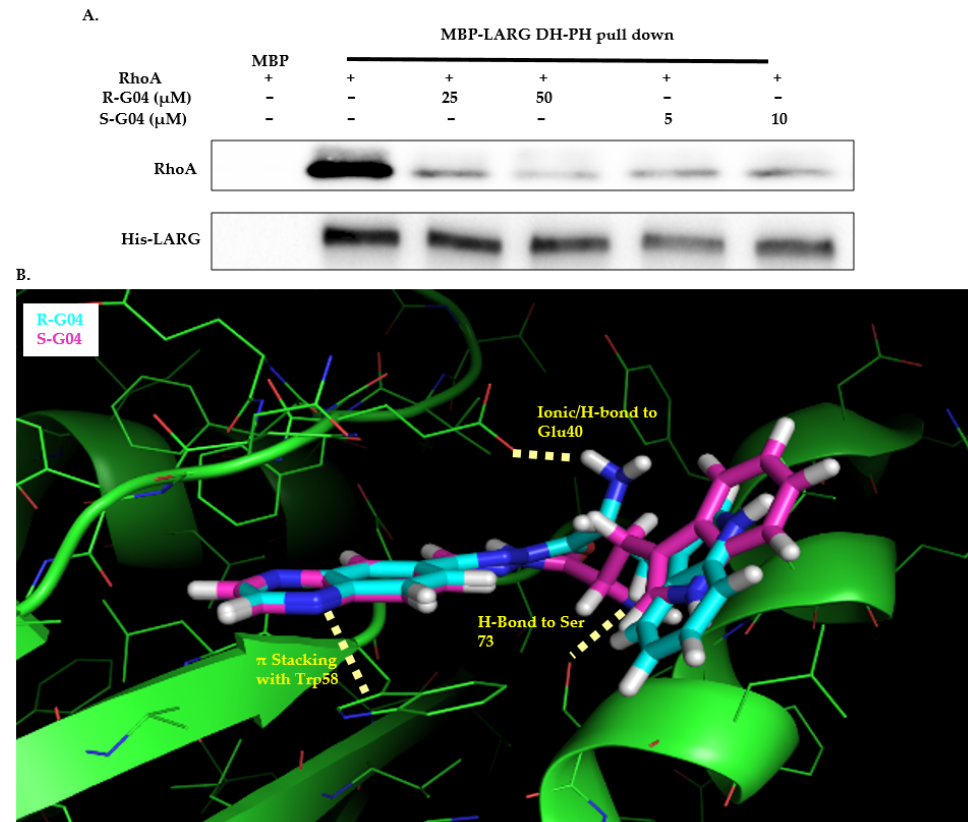
Figure 6. R-G04 and S-G04 inhibit RhoA-LARG interaction. ( A ) A complex-formation assay tested the inhibitory effects of R-G04 and S-G04 on RhoA interaction with the LARG DH-PH domain. MBP-(His)6-tagged LARG (100 ng) was immobilized on Amylose beads. Binding buffer containing full-length RhoA (100 ng) was pre-incubated with different concentrations of R-G04 (25 µM or 50 µM), and S-G04 (5 µM or 10 µM) was added to the beads. After incubating the compound-RhoA-LARG mixture at 4 °C for 1 h, the beads associated with RhoA were detected with anti-RhoA Western blotting. ( B ) Top view of the predicted structural contacts of R-G04 and S-G04 in the binding pocket around the Trp58 residue of RhoA.